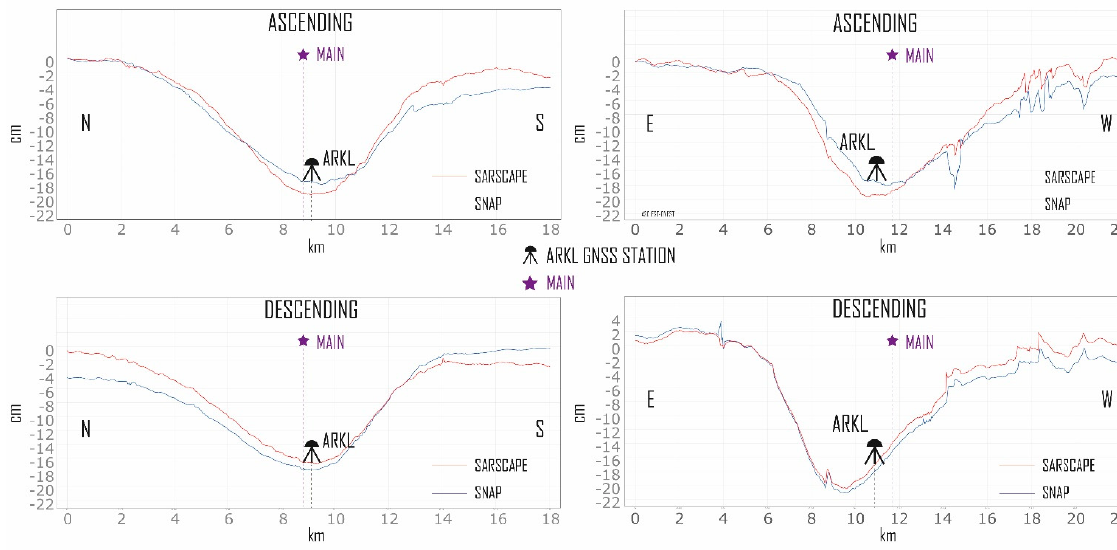
Figure 5. Cross sections along the S-N and E-W transects shown in Figure 4.